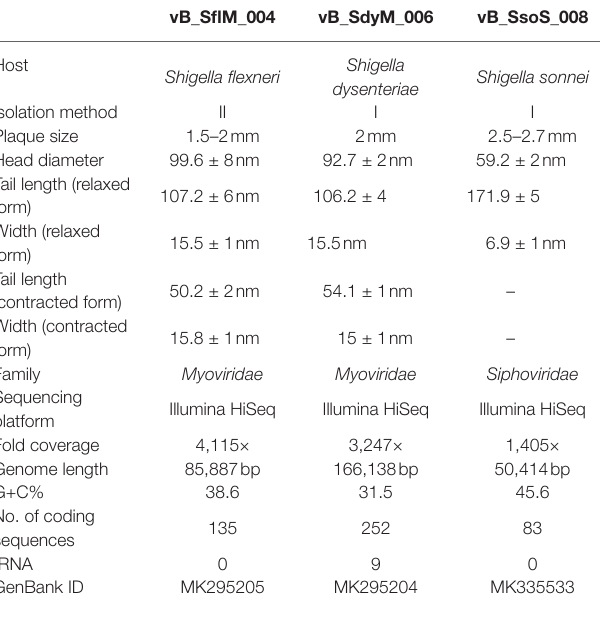
TABLE 1 | Morphologic and genomic characteristics of the isolated phages in current